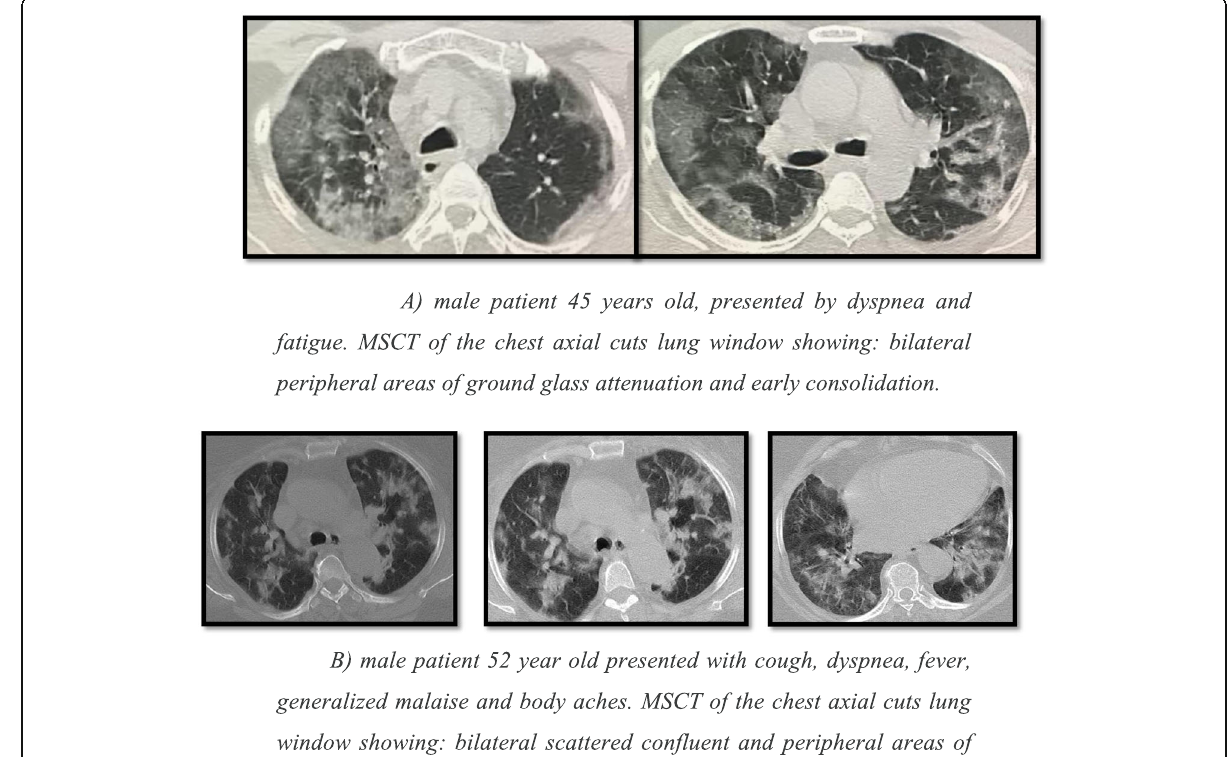
Fig. 1 a Male patient, 45 years old, presented by dyspnea and fatigue. MSCT of the chest axial cuts the lung window showing bilateral peripheral areas of ground-glass attenuation and early consolidation. b Male patient, 52 years old, presented with cough, dyspnea, fever, generalized malaise, and body aches. MSCT of the chest axial cuts the lung window showing bilateral scattered confluent and peripheral areas of ground-glass attenuation and early